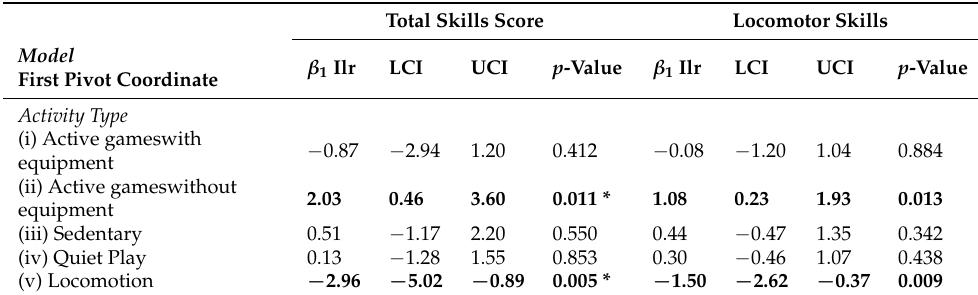
Table 3. Summary of associations between FMS outcomes and play behavior activity type isometric log-ratio regression estimates (pivot